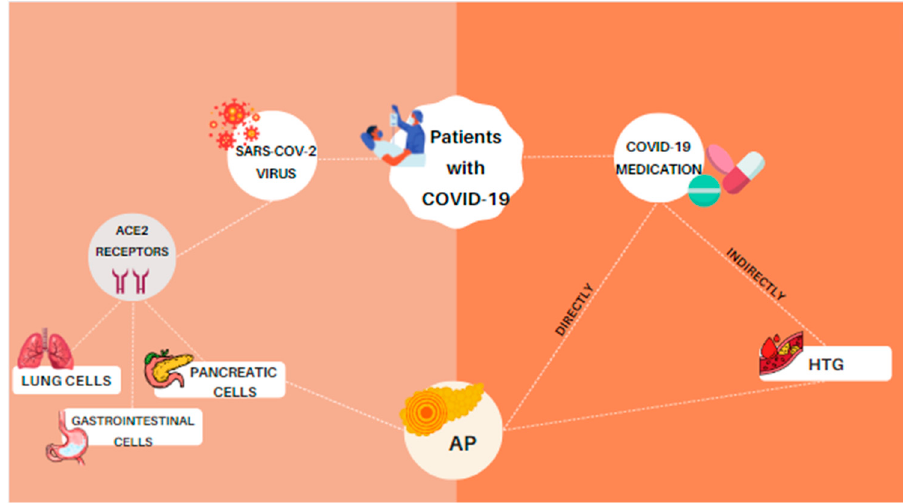
Figure 1. SARS-CoV-2 invades the host cells using ACE2 receptors, which are normally expressed not only in lung parenchyma, but also in pancreatic and gastrointestinal cells. A potential cause of AP is the infection of pancreatic cells, though another, less common cause is related to the medications that patients who are hospitalized with COVID-19 receive. These drugs may cause direct or indirect pancreatic damages via hypertriglyceridemia.